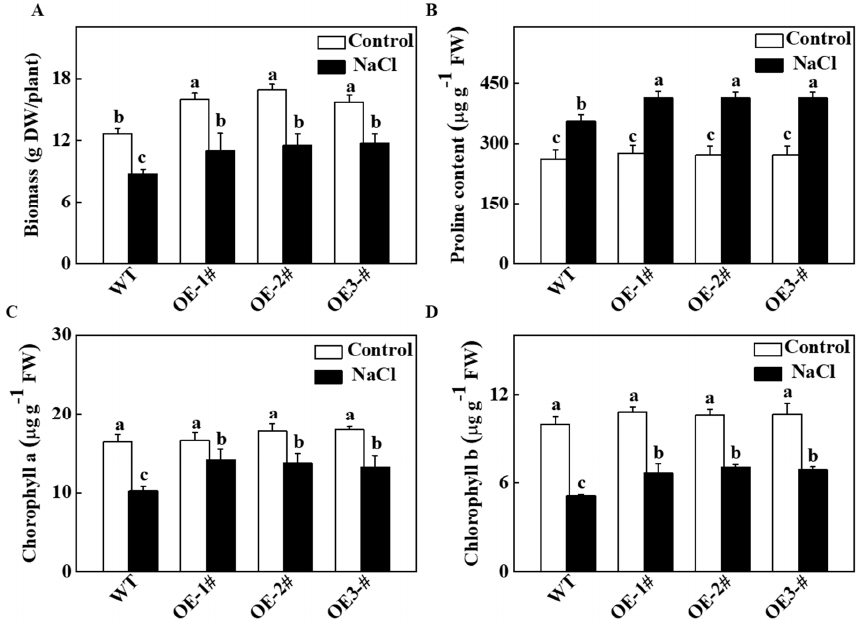
Figure 3. Effects of salt stress on biomass, proline and chlorophyll content in wild-type (WT) and CsTGase OE plants. ( A ) Biomass. ( B ) Proline content in leaves. ( C , D ) Chlorophyll a and b content. Each histogram represents a mean ± SE of four independent experiments ( n = 4). Different letters indicate significant differences between treatments ( p < 0.05) according to Duncan’s multiple range test.